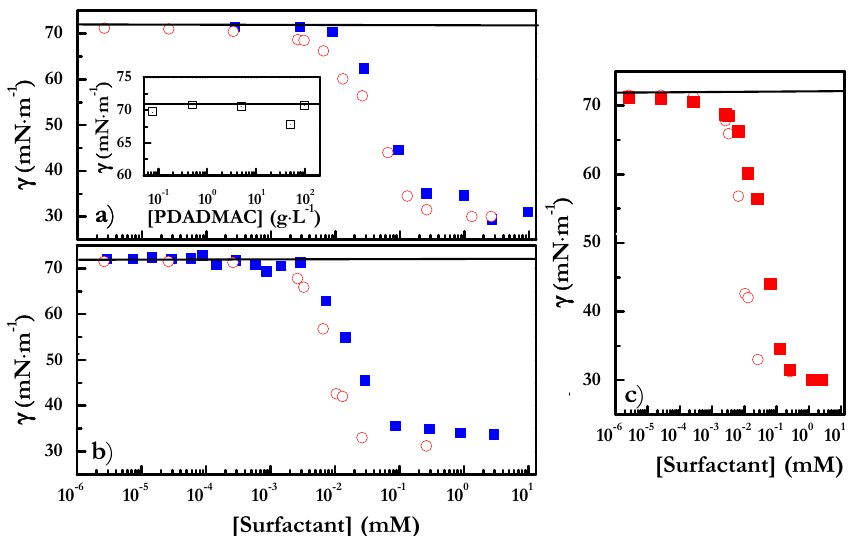
Figure 4. Surface tension isotherms, as were obtained using a drop shape tensiometer. ( a ) Surfactant solutions: SLMT ( ■ ) and SLES ( ○ ). The inset shows the surface tension isotherm for PDADMAC solutions as function of the concentration. ( b ) PDADMAC–surfactant solutions with a fixed polymer concentration of 5 g/L: PDADMAC–SLMT and ( ■ ) and PDADMAC–SLES ( ○ ). The solid lines represent the surface tension of the pure Milli-Q water used in this work. ( c ) Comparison of surfactant and PDADMAC–surfactant solutions: SLES ( ■ ) and PDADMAC–SLES with a fixed polymer concentration of 5 g/L ( ○ ). The solid lines represent the surface tension of the pure Milli-Q water used in this work.